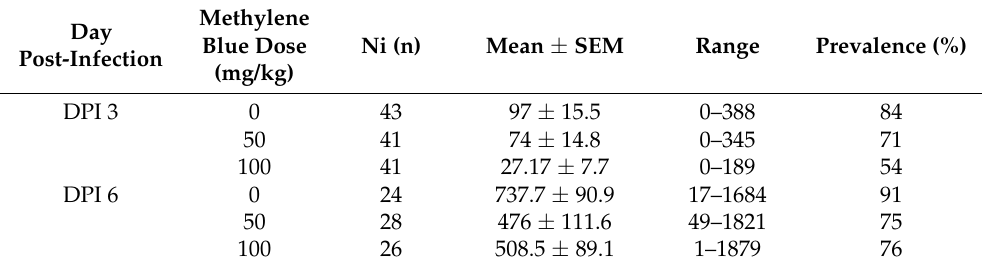
Table A2. Preliminary infected mosquitoes were divided into three groups, which received secondary blood meals dosed with 0 (control), 50 and 100 mg/kg MB 3- and 6-days pi. Infection intensity (Oocyst density) and infection rate (prevalence of oocyst) were estimated by counting the oocyst in the mosquito midguts. Ni Number of mosquitoes in each treatment group. Day 3; p = 0.38 for mean oocysts comparisons of MB 50 mg/kg vs. control; p = 0.0005 for comparisons of MB 100 mg/kg vs. control. Day 6; p = 0.052 for comparisons of MB 50 mg/kg vs. control; p = 0.074 for comparisons of MB 100 mg/kg vs. control.